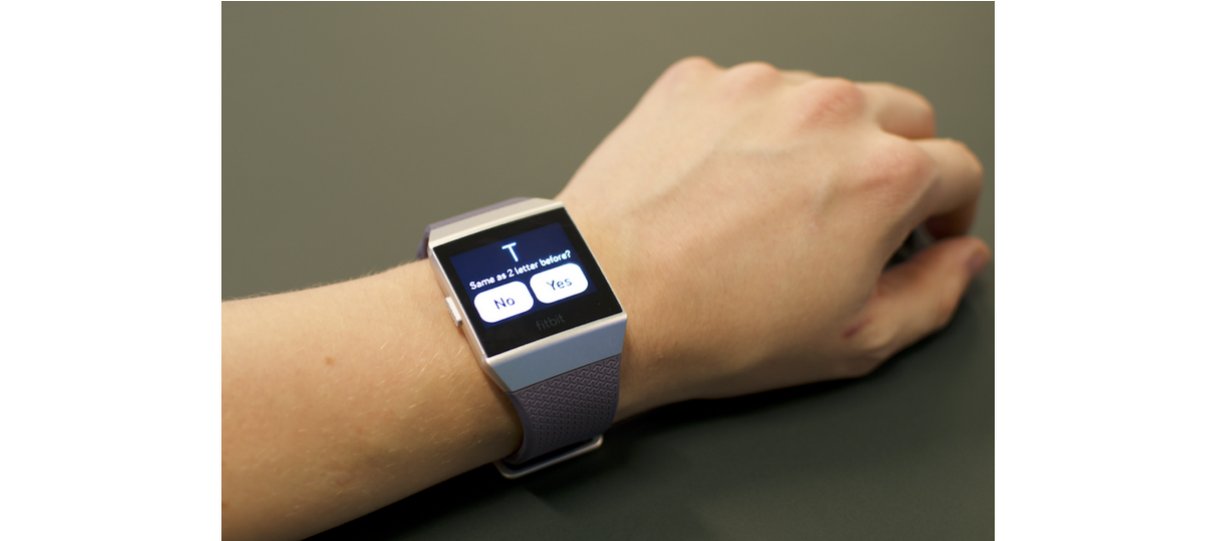
Figure 2. A sample test taken from the UbiCAT (Ubiquitous Cognitive Assessment Tool) Letter test, 2-back task. The participant should indicate whether “T” appeared 2 letters back in the sequence or